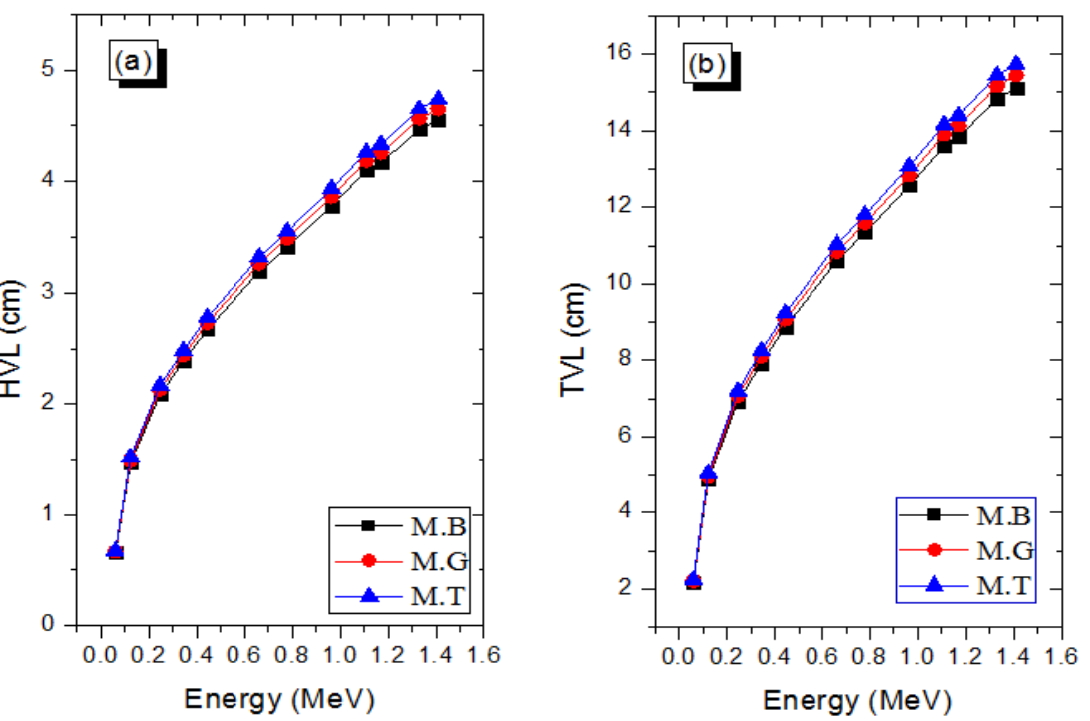
Figure 5. Changes in the ( a ) HVL and ( b ) TVL with E for the